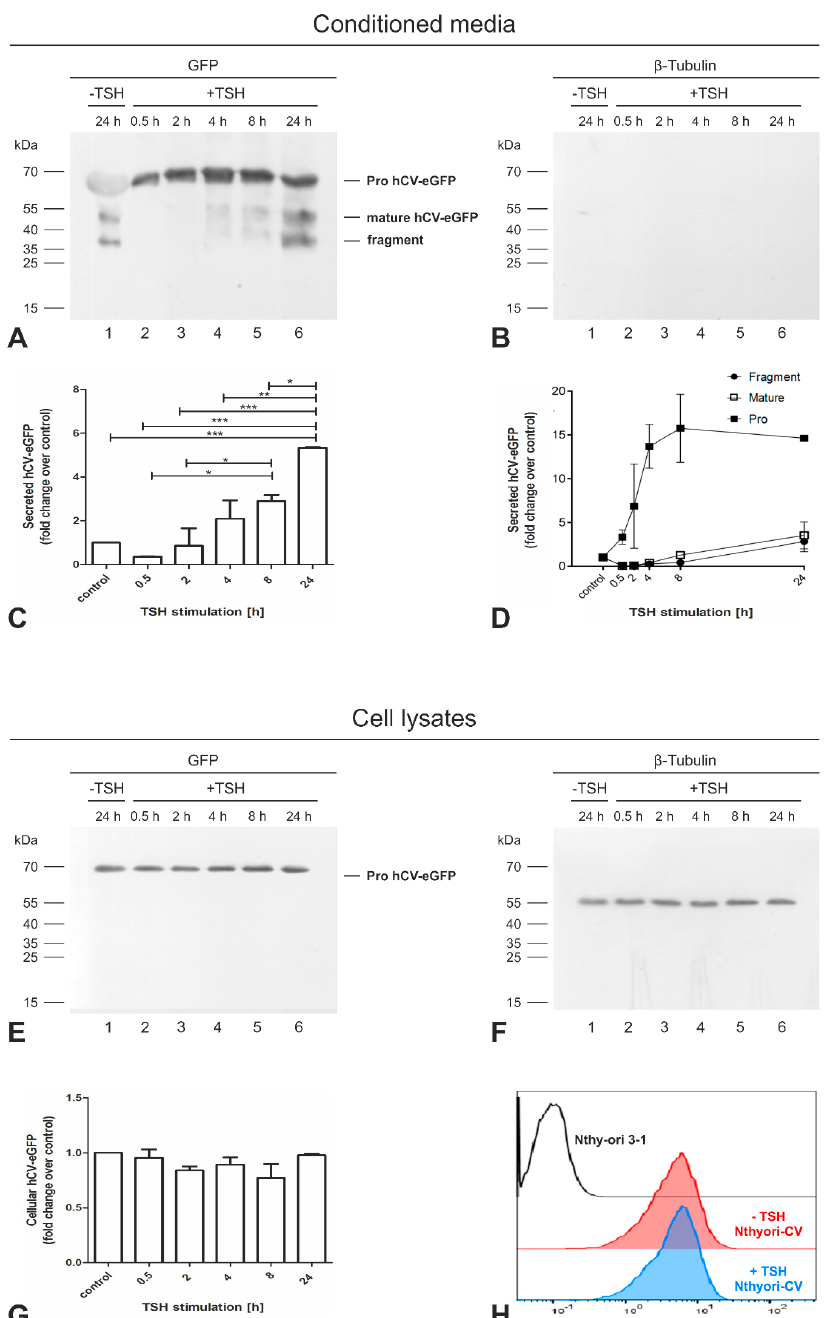
Figure 7. TSH regulates the secretion of the proform of hCV-eGFP chimeric protein from thyroid epithelial cells. Proteins precipitated with TCA from the conditioned media of confluent